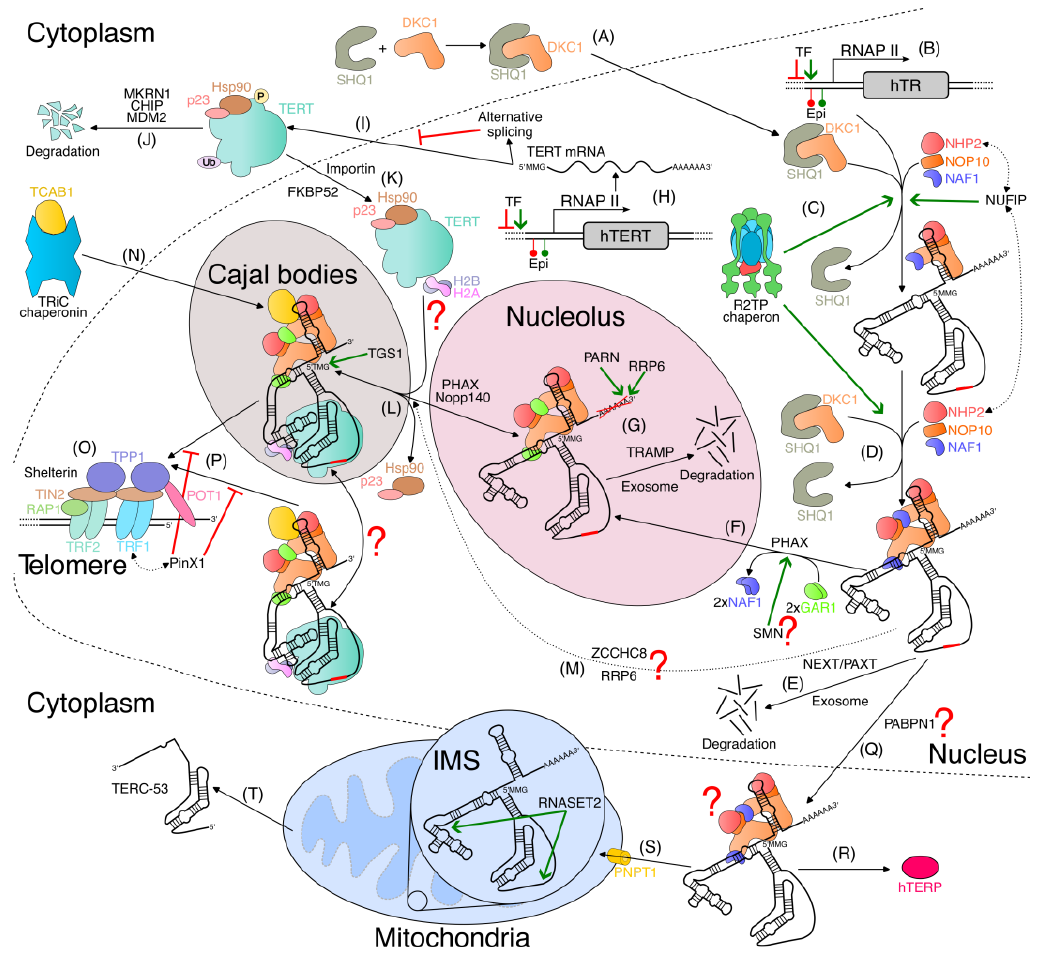
Figure 4. Model of human telomerase complex and telomerase RNA biogenesis. ( A ) After its synthesis, dyskerin (DKC1) is stabilized by SHQ1 protein in the cytoplasm and transported into the nucleus. ( B ) Telomerase RNA (hTR) is expressed as a 3′ poly(A) precursor monomethylated at the